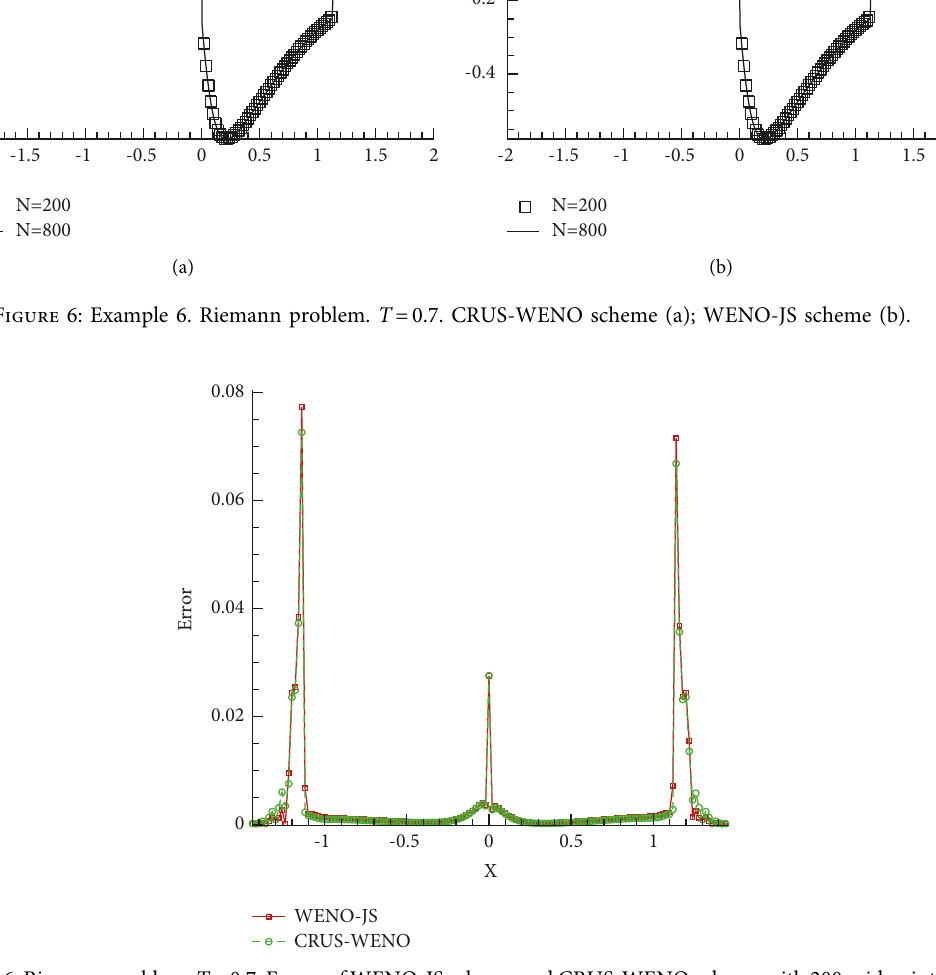
Figure 7: Example 6. Riemann problem. T � 0.7. Errors of WENO-JS scheme and CRUS-WENO scheme with 200 grid points. The reference solution is computed by WENO-JS scheme with 800 grid points.